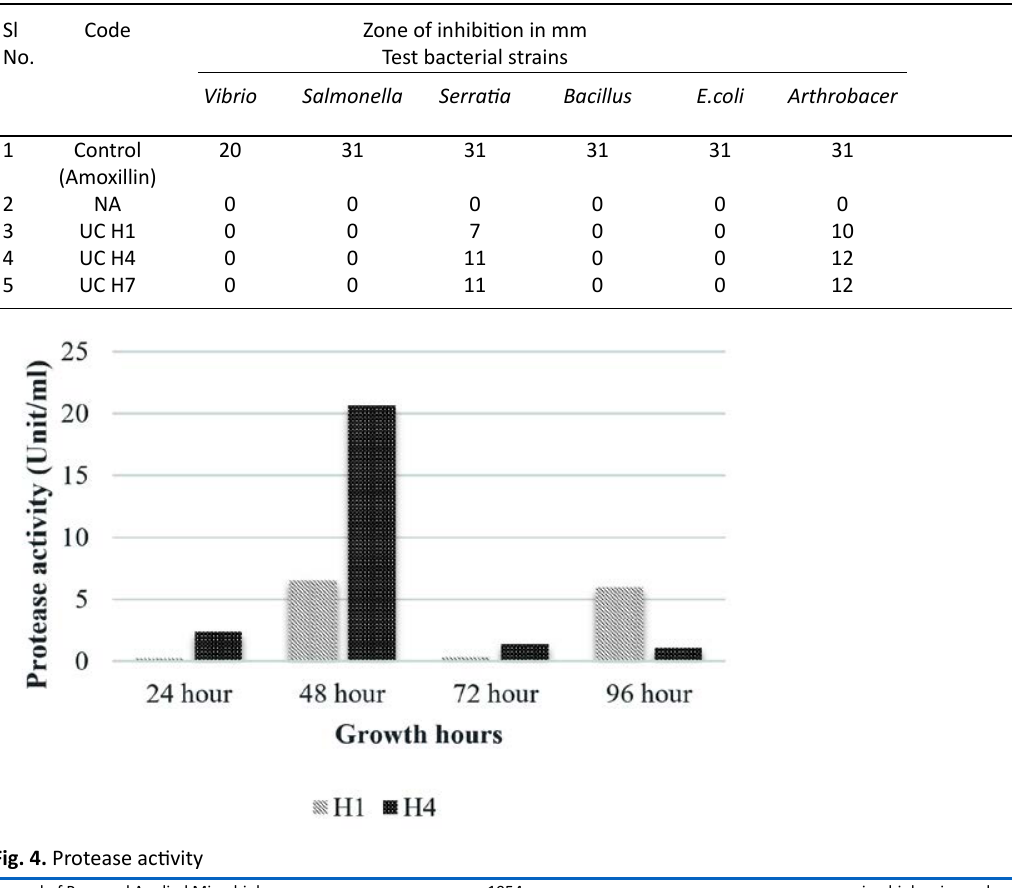
Fig. 4. Protease activity